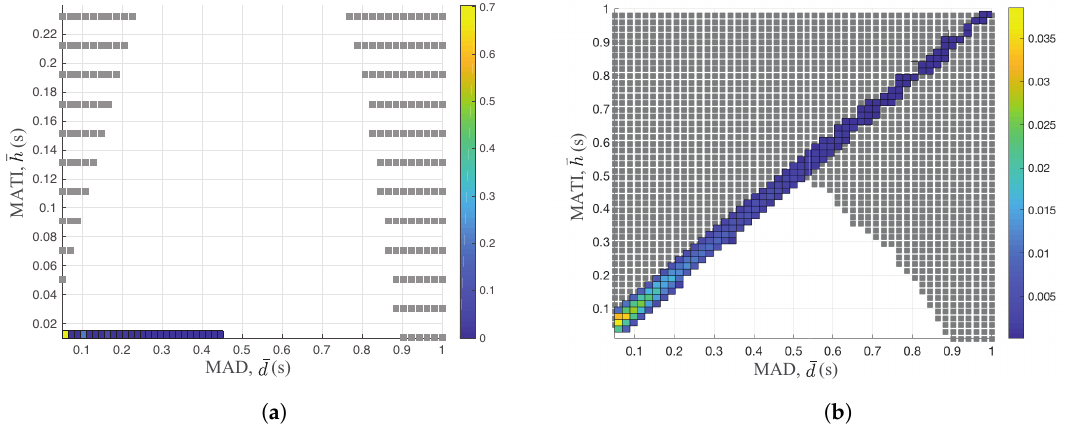
Figure 4. Transmission interval and delay of both TDMA and slotted Aloha schemes over the stability region: ( a ) TDMA performance over stability region; and ( b ) slotted Aloha performance over stability